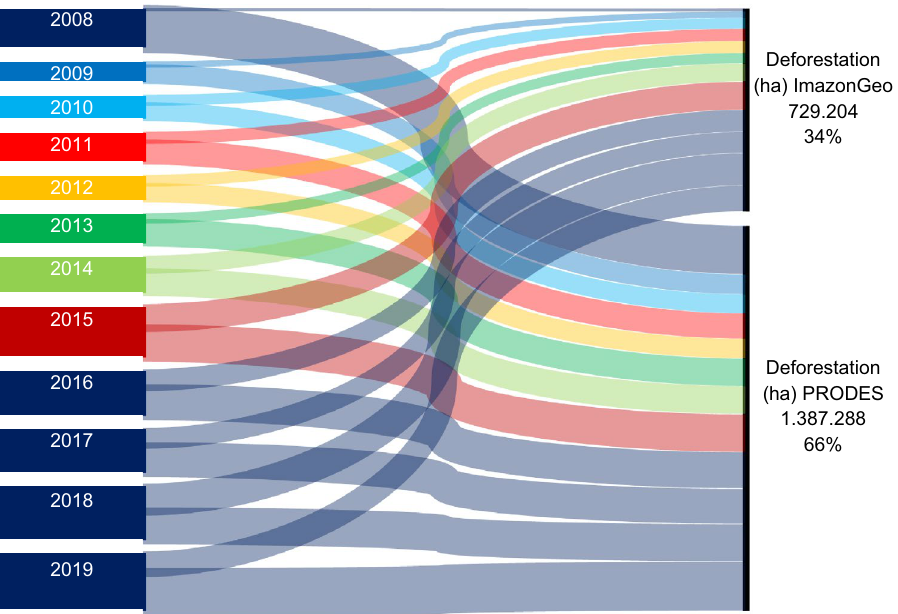
Figure 4. Sankey diagram showing, from the thickness of the lines and similar colors, the flows of deforestation variation over the years for PRODES and ImazonGeo during August 2008 to October